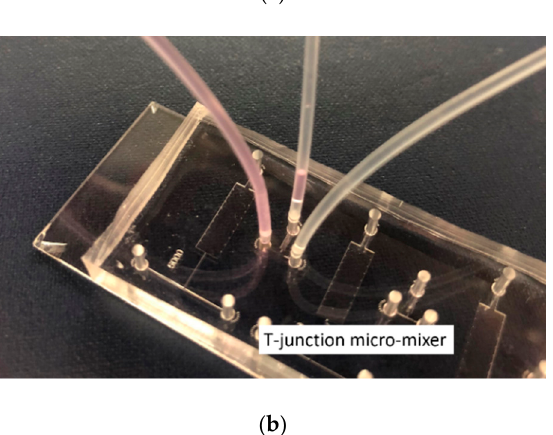
Figure 1. ( a ) The design and ( b ) the fabricated chip of the T-junction microfluidic mixer.